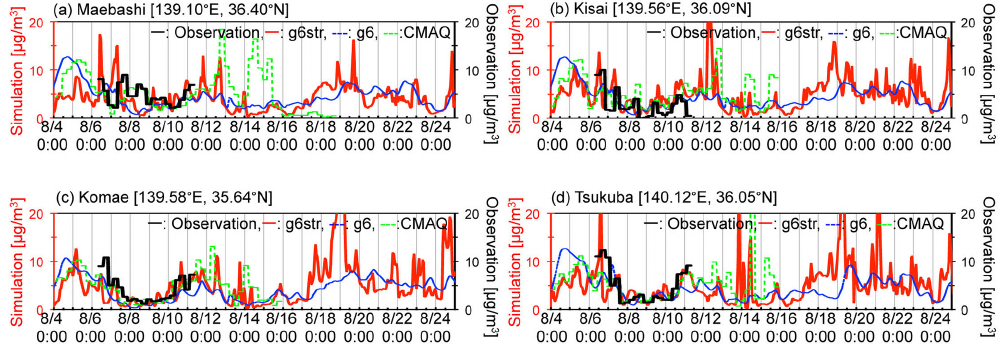
Figure 12. Same as Fig. 11 but for